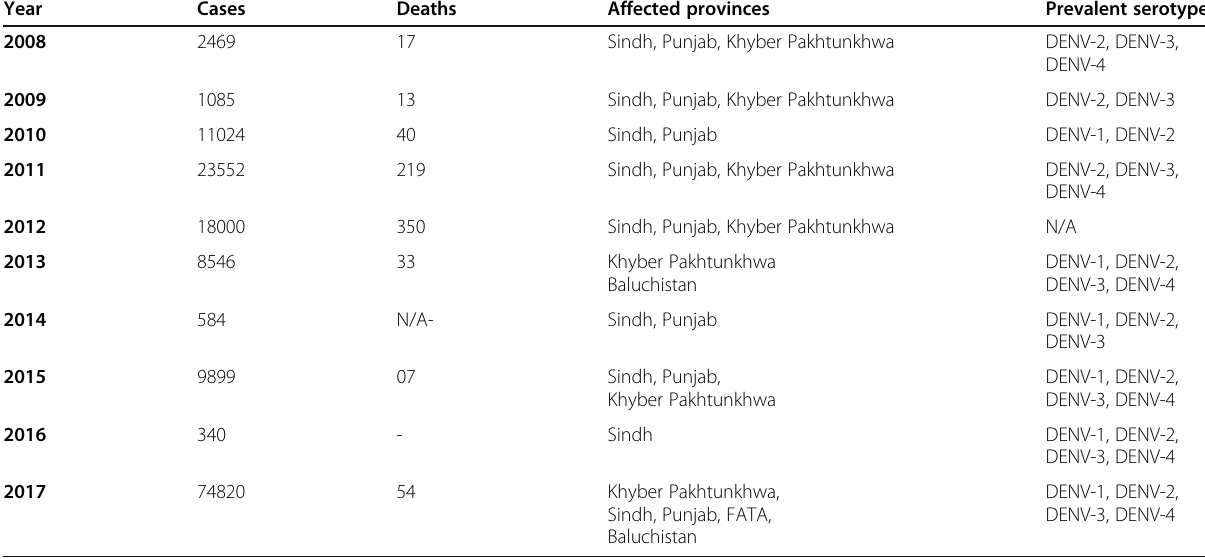
Table 1 Dengue-infected cases, deaths, and prevalent serotypes from affected areas of Pakistan (Ahmad et al. 2017) Year Cases Deaths Affected provinces Prevalent